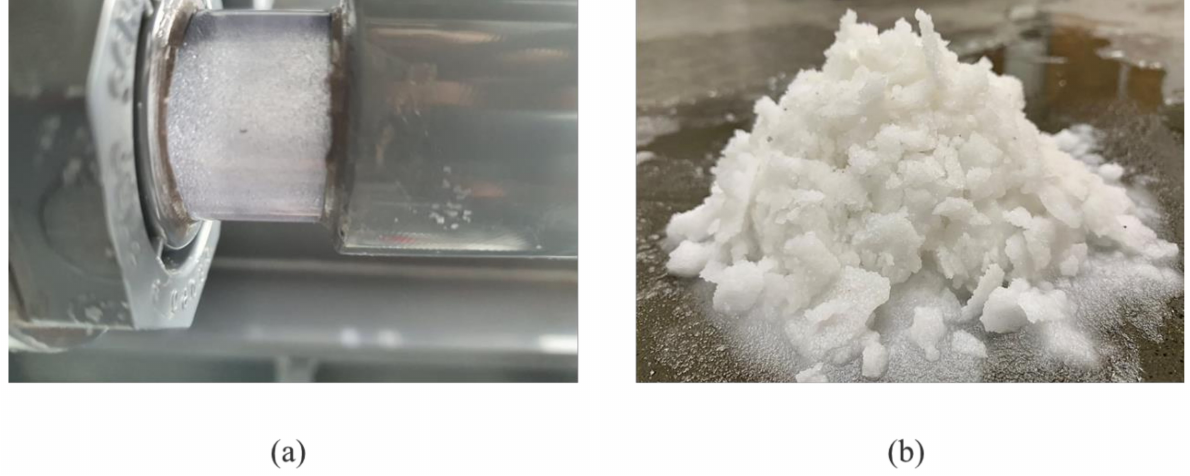
Figure 6. ( a ) Formation of salt crystals in the crystallizer, and ( b ) sea salt recovered from the